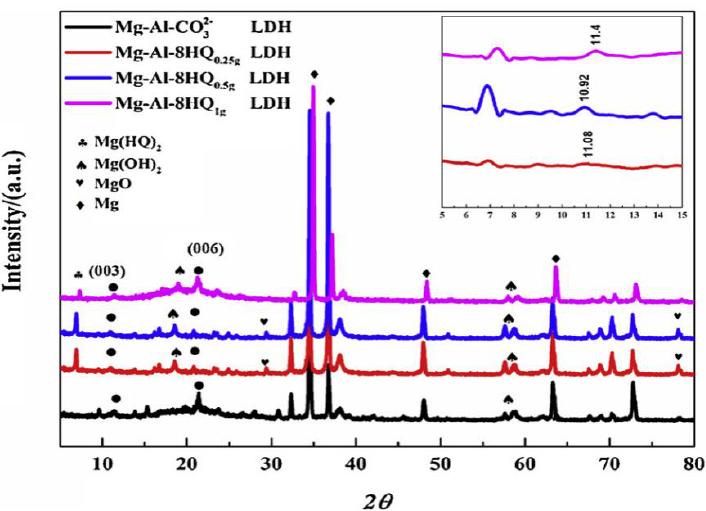
Figure 19. XRD patterns of AZ31 with Mg-Al-CO 32 − and Mg-Al-8HQ xg (x = 0.25, 0.5 and 1) LDH coatings. Adapted from [228] with permission from Elsevier.